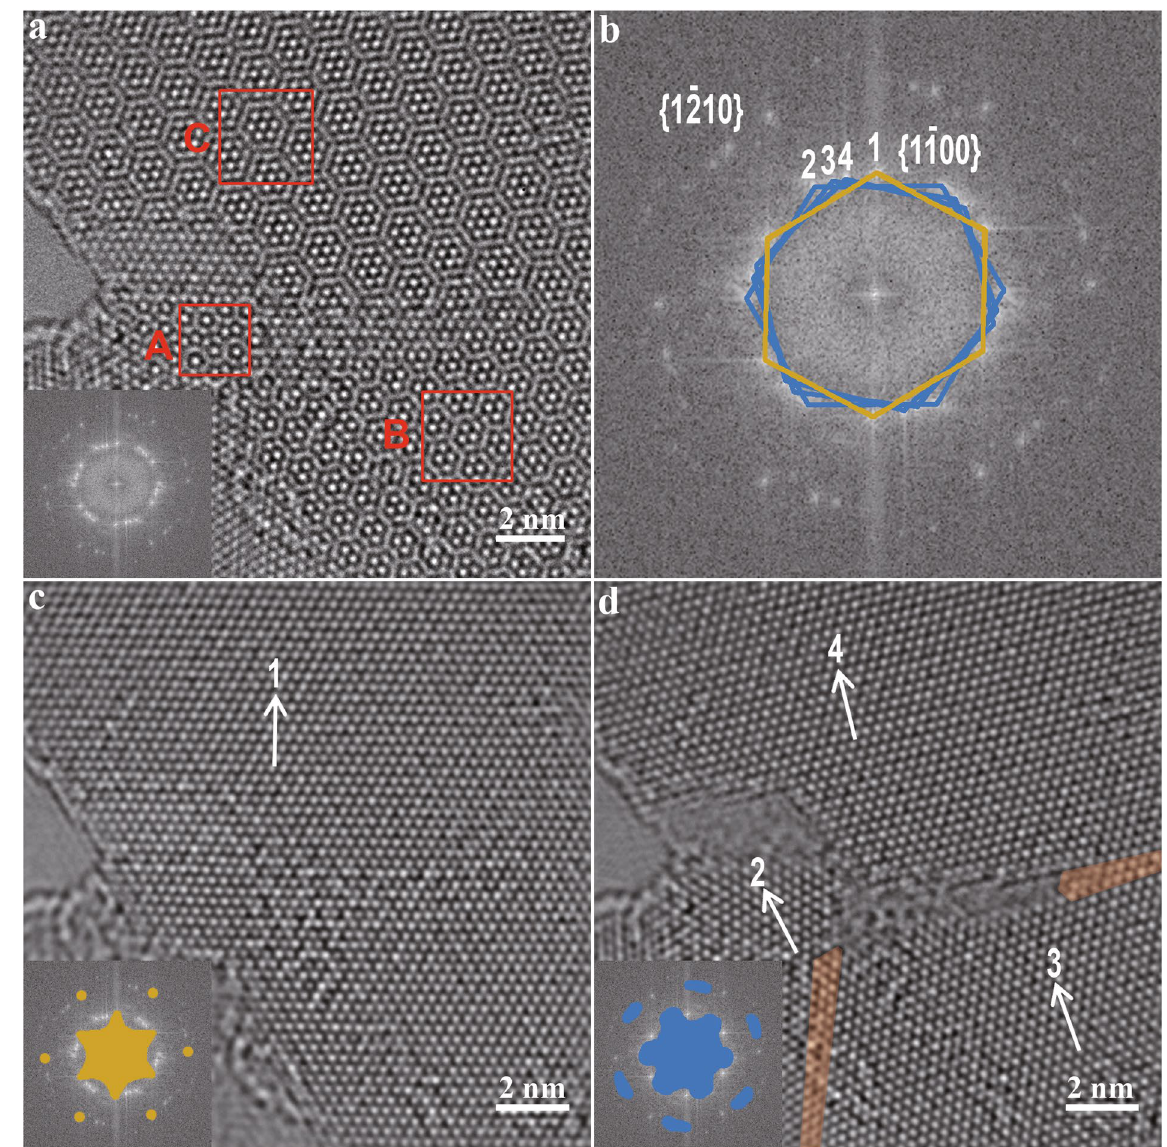
Figure 2. HRTEM images and FFT patterns of a freestanding bilayer MoS 2 sheet with three RSFs. ( a ) HRTEM image of the sheet containing three Moiré patterns, whose typical zones are marked with the red boxes of A, B and C. This HRTEM image is raw and unfiltered, and the inset is its FFT pattern. ( b ) Enlargement of the FFT pattern in ( a ), where the twenty-four ¯ {1100} spots constitute four hexagons that are annotated with 1 to 4. Hexagon 1 is highlighted in yellow and the others are in blue. ( c ) HRTEM image reconstruction by the inverse FFT (IFFT) of the information covered by the yellow mask in the inset. The inset is the same image as in ( b ) except that a mask has been applied to exclude Hexagons 2 to 4 and their associated ¯ {1210} spots. ( d ) HRTEM image reconstruction by the IFFT of the information covered by the blue mask in the inset. The blue mask excludes Hexagon 1 and its associated ¯ {1210} spots. The semitransparent orange masks in the main panel of ( d ) highlight two dislocations. The arrows in ( c , d ) indicate the ¯ [1100] orientations corresponding to Hexagons 1 to 4,